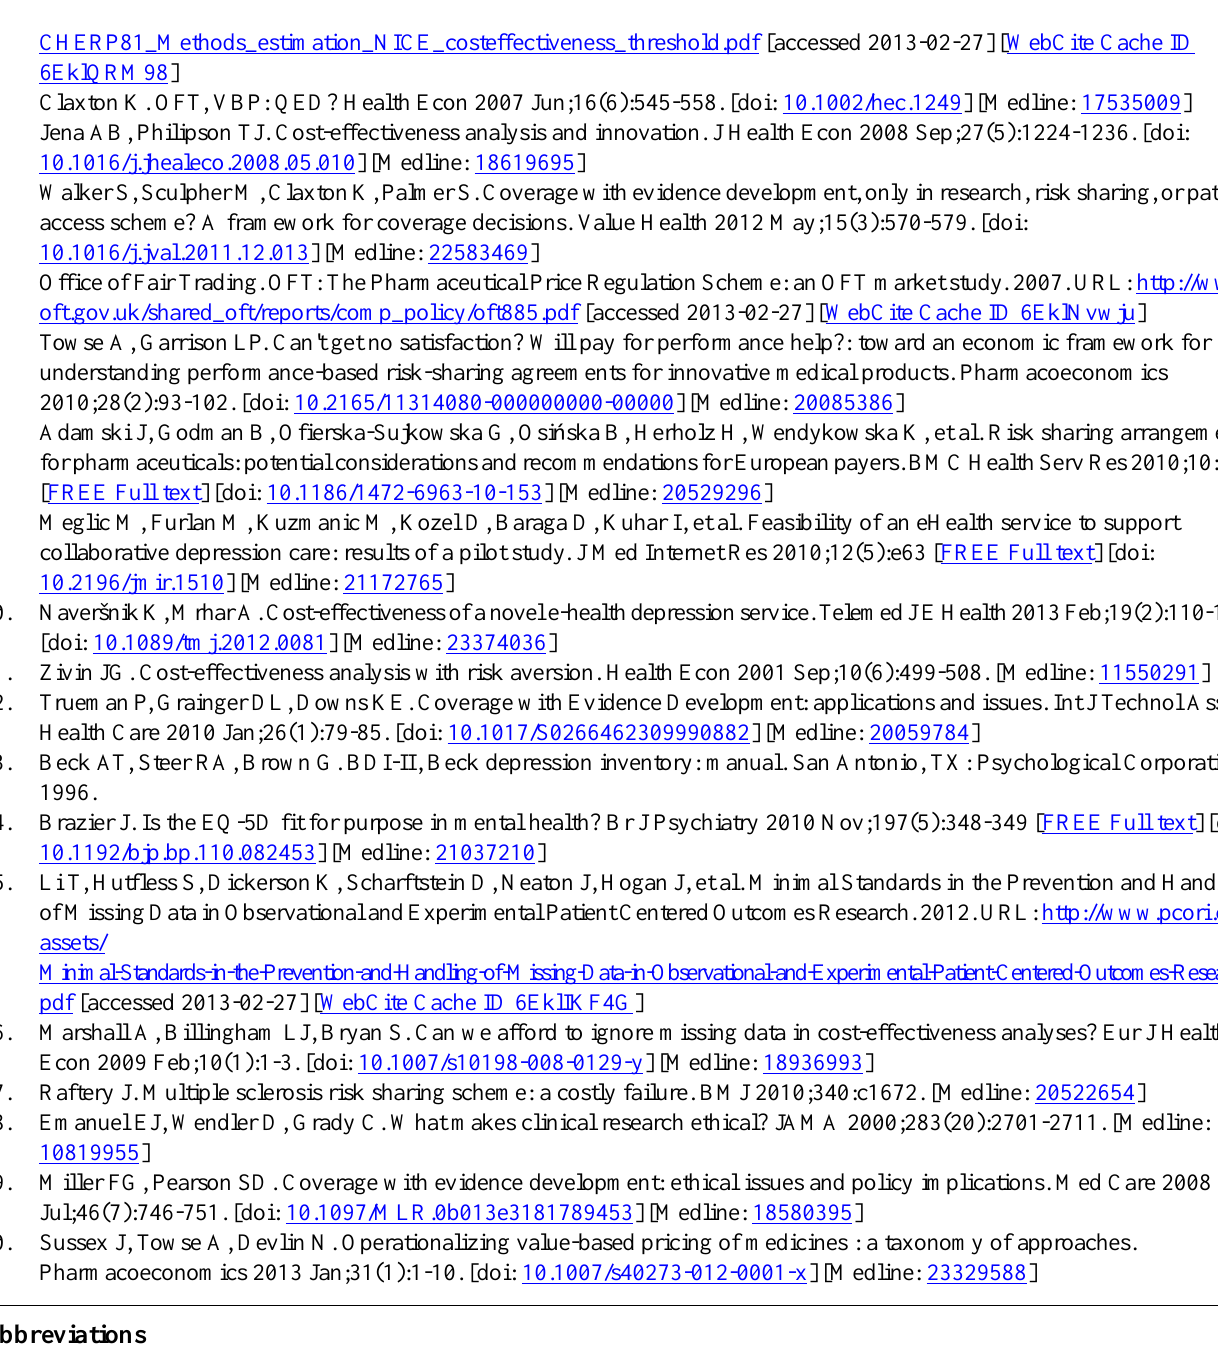
BDI: Beck Depression Inventory CE: cost-effectiveness ICER: incremental cost-effectiveness ratio QALY: quality-adjusted